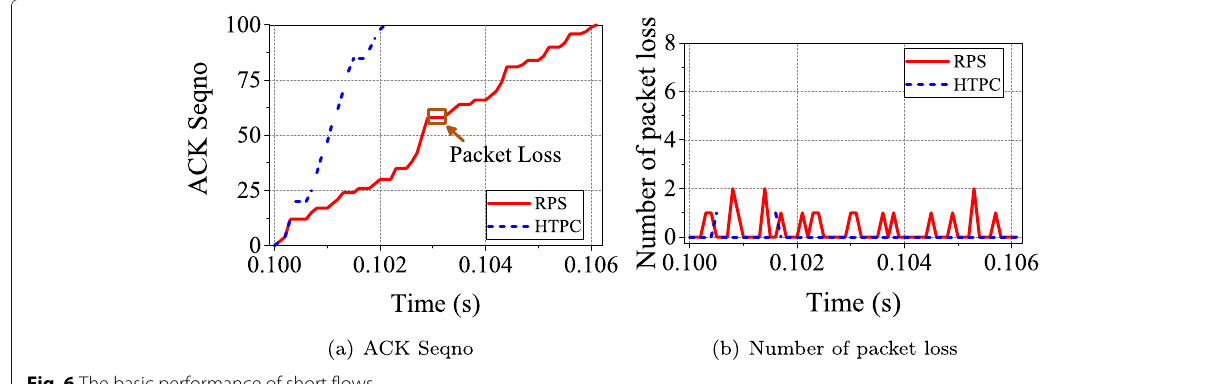
Fig. 6 The basic performance of short flows